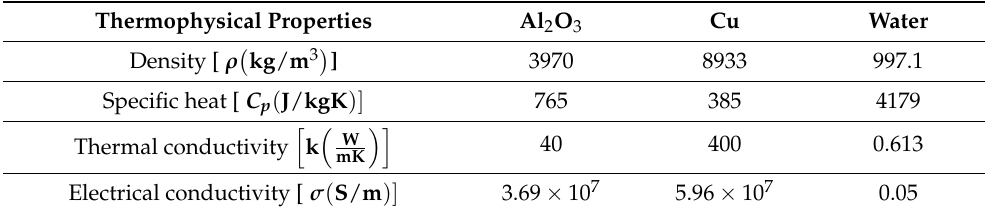
Table 1. Thermophysical properties of solid nanoparticles (Al 2 O 3 and Cu base liquid (water) [33,34].